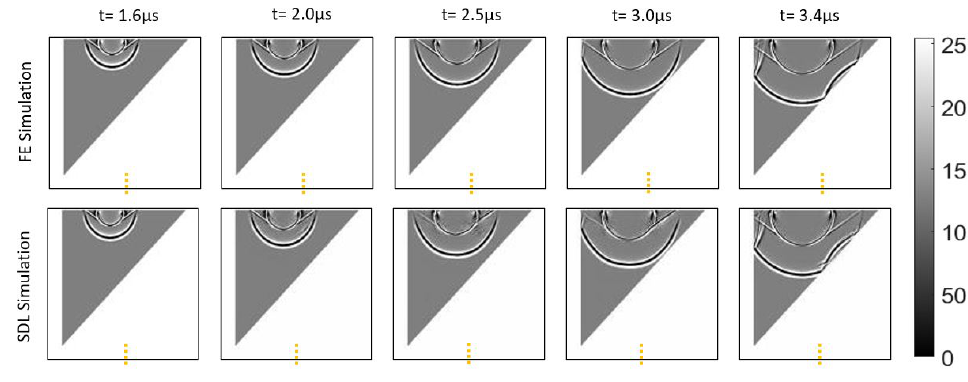
Figure 6. Reflected wave propagation with different geometrical boundaries: FE and SDL models are used to simulate reflected wave propagation in different geometrical boundaries. The simulations generated using FE and SDL are compared to each other at identical time steps for different time instances. These simulations are modeled with an incident wave of 5 MHz frequency with two cycles, using a single-point excitation source on the top edge. ( a ) Represents the FE/SDL simulation for the curved domain, ( b ) illustrates the FE/SDL wave propagation simulation for the T-shaped domain, and ( c ) shows the wave propagation simulation for the triangular domain. For the illustration, a yellow dashed vertical line is created, manually, in all the frames, to extract the displacement values.